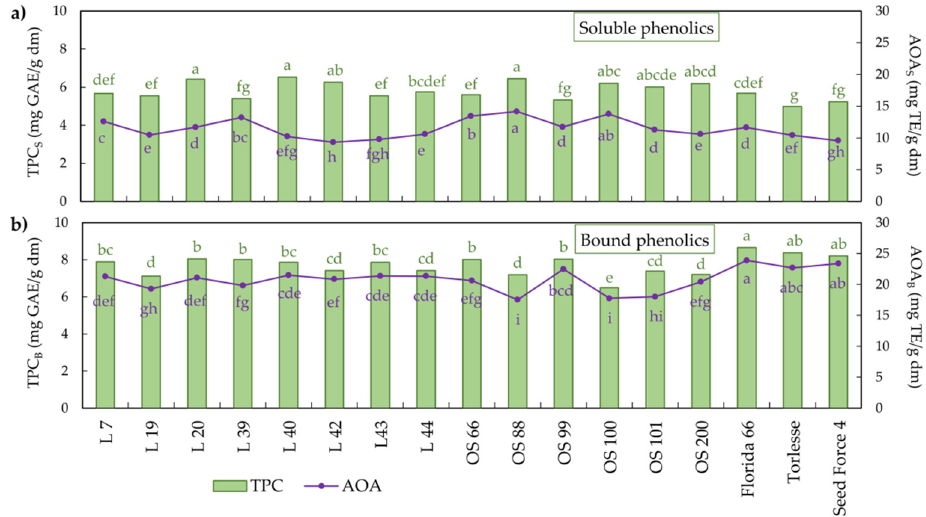
Figure 1. Mean values of TPC and AOA of soluble ( a ) and bound ( b ) phenolic extracts of alfalfa. Different letters indicate significant difference among accessions at p < 0.05 according to the LSD test. TPC—total phenolic content; AOA—antioxidant activity of soluble ( S ) and bound ( B ) phenolics.